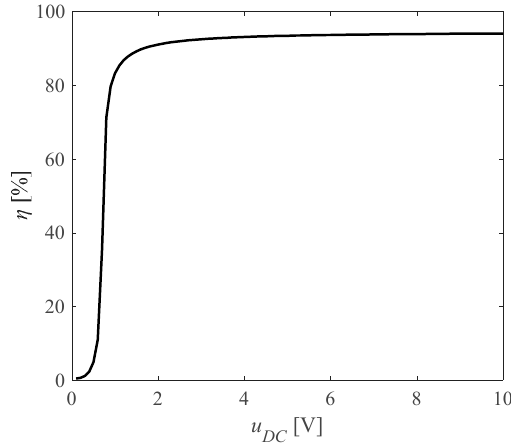
Figure 7. Efficiency η vs. voltage u DC . Table 2. Power consumption of the driver unit.